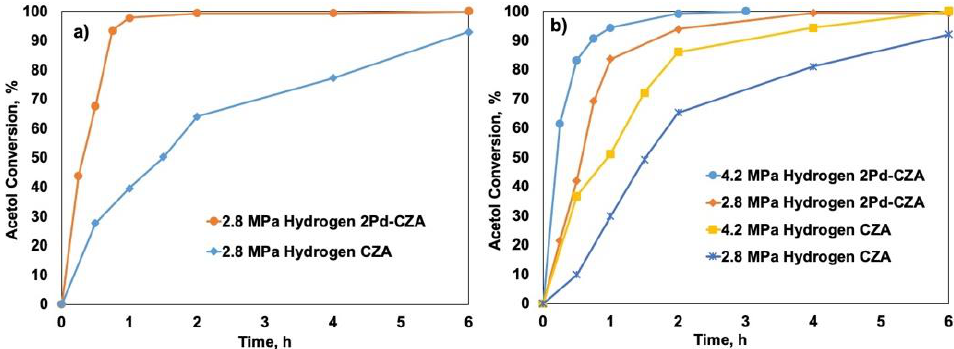
Figure 8. Promoting effect of 2 wt% Pd on a CZA catalyst for acetol hydrogenation: ( a ) 10 wt% aqueous acetol; ( b ) 20 wt% aqueous acetol. Reaction conditions: 200 ◦ C, 500 RPM, 6 h reaction time, 5 wt% of catalyst with respect to acetol weight. CZA: Cu/Zn/Al (molar) = 35/35/30.